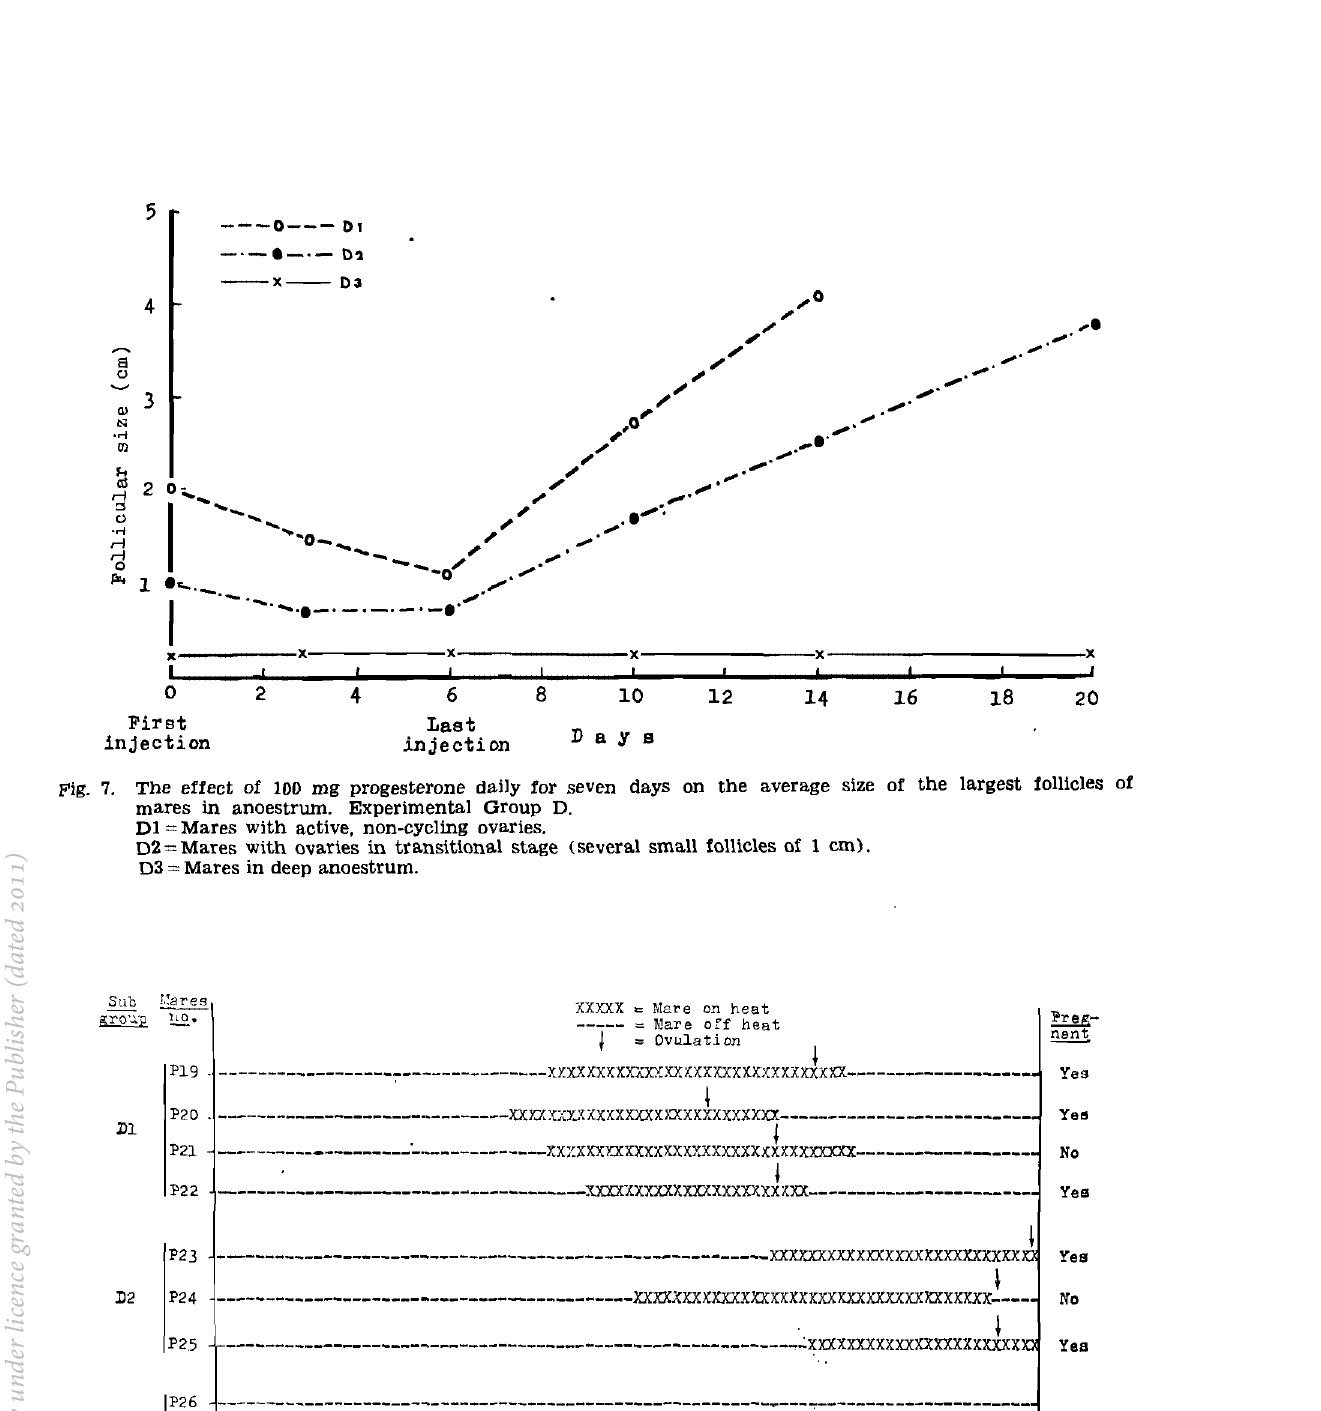
Fig, 8. The effect of progesterone treatment on oestrus and OVUlation in mares in anoestrum, GrouD D.